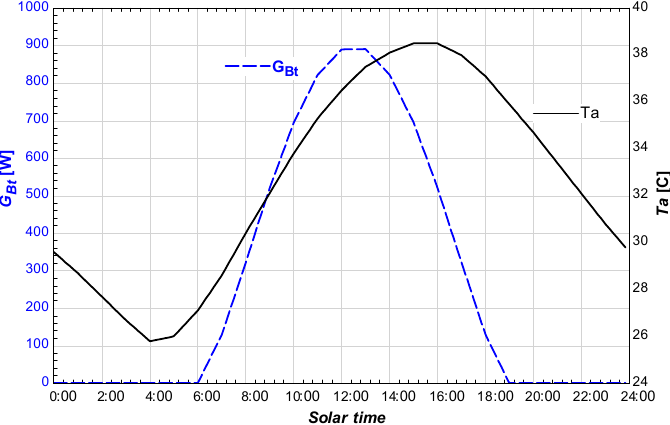
Figure 3. Beam (direct) solar radiation G Bt received by the PTC facing South and tilted at β = 30° and ambient temperature T a in Bucharest, on 15 July; Data generated with Meteonorm V7.1.8.29631 [21] .